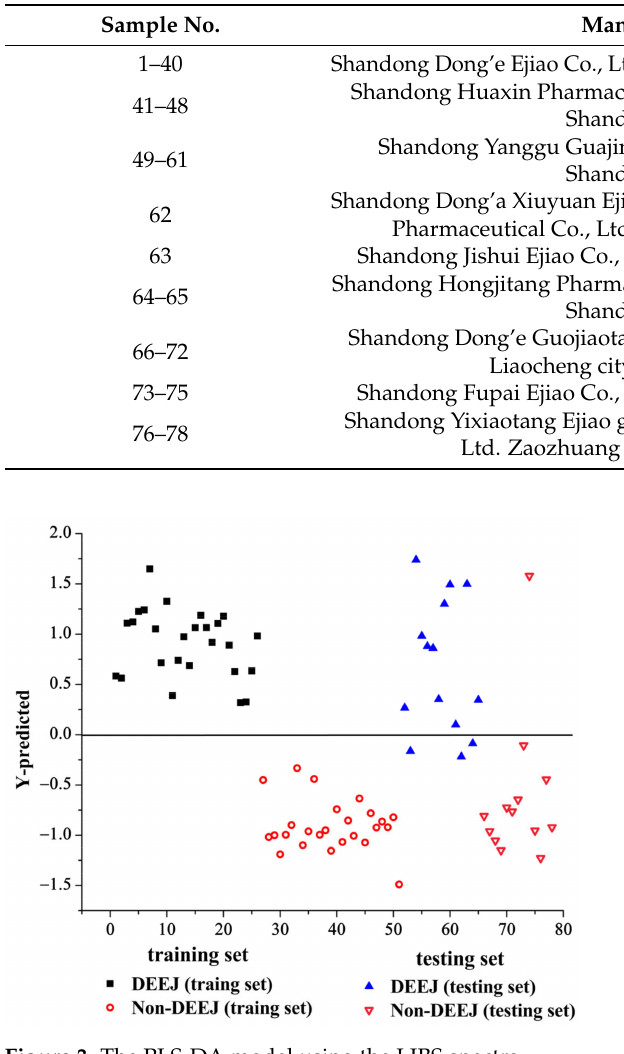
Figure 3. The PLS-DA model using the LIBS